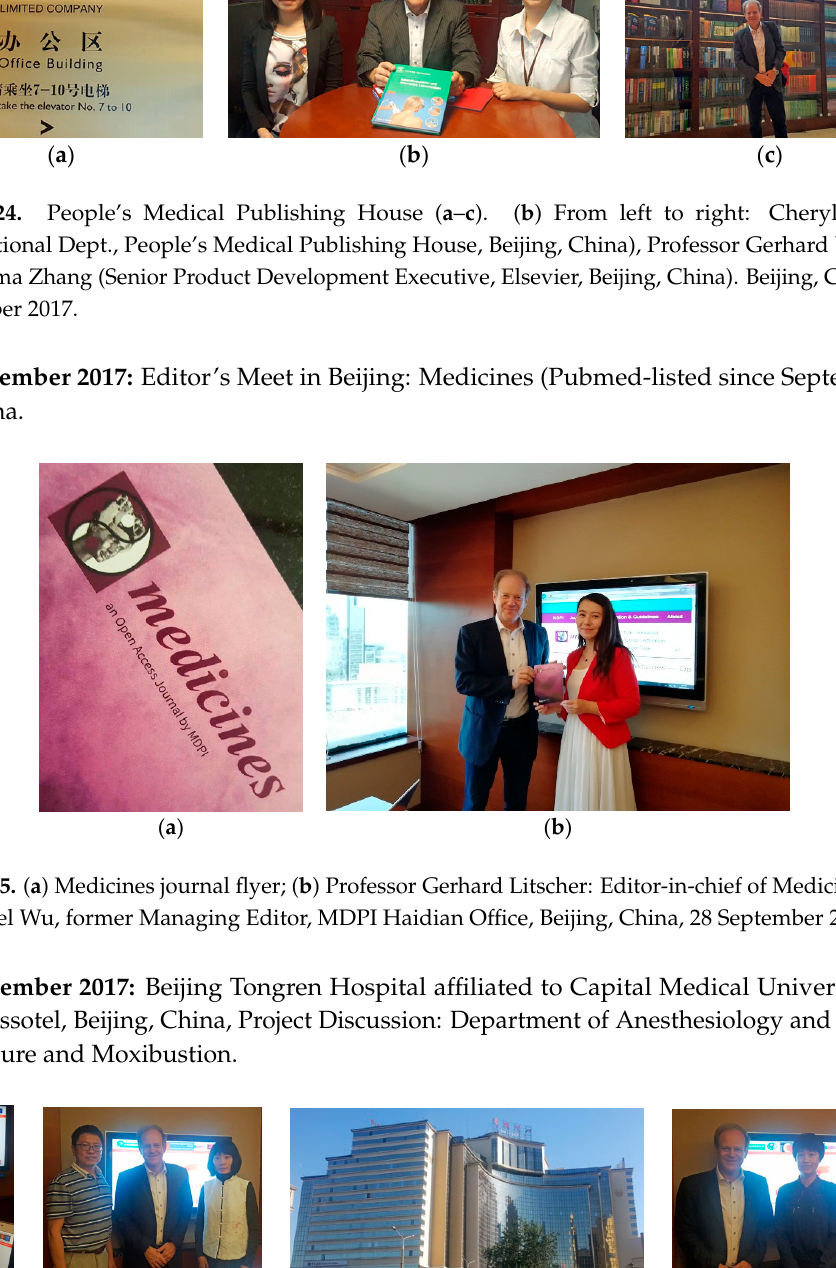
Figure 26. Project Meeting ( a ) at Swissotel, Beijing ( c ). ( b ) From left to right: Professor James Chen,